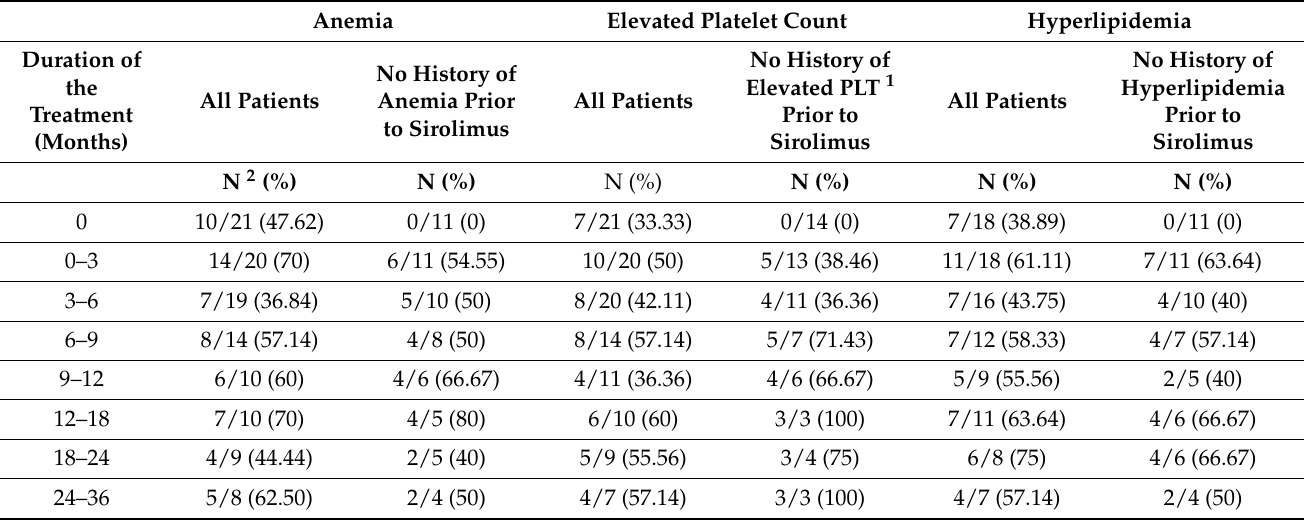
Table 3. Anemia, thrombocytosis and hyperlipidemia as an adverse effect depending on the duration of treatment.